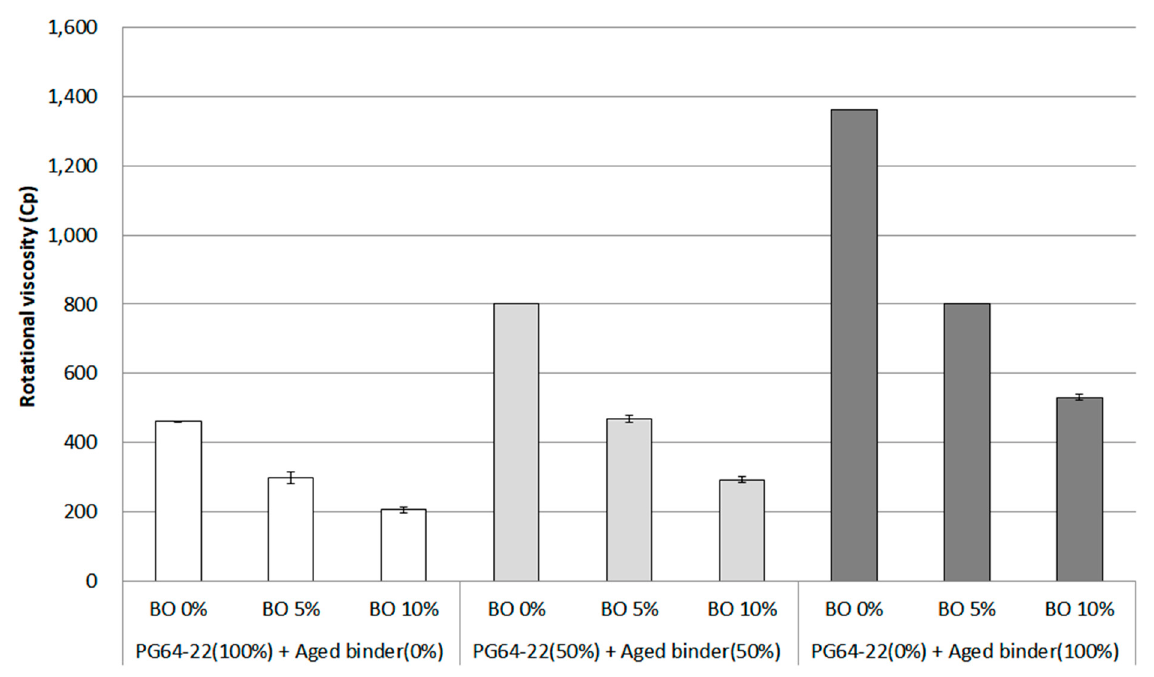
Figure 4. Rotational viscosity of each asphalt binder containing the base oil at 135 °C.